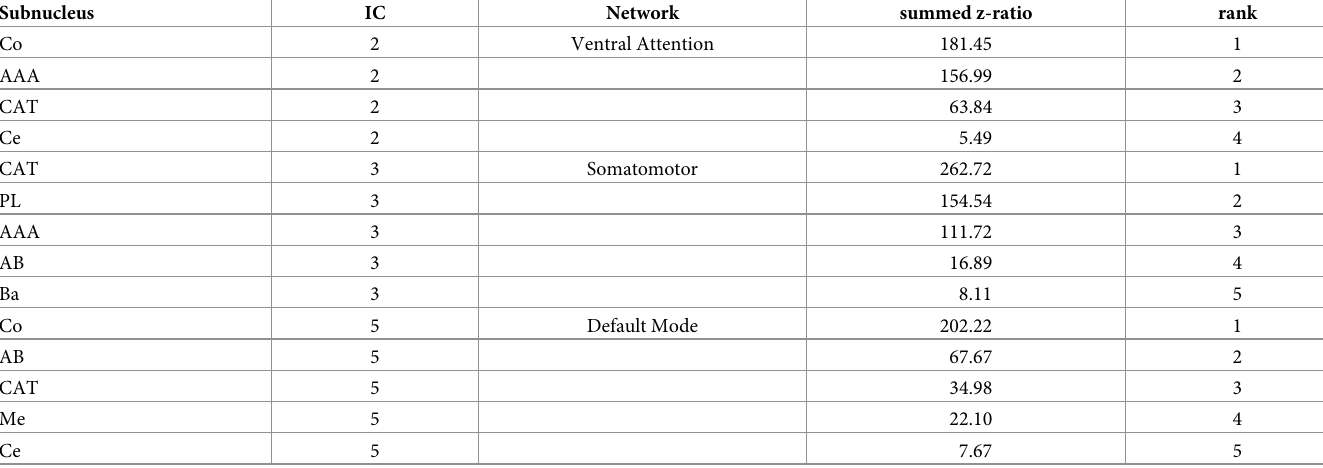
Table 7. Relative contributions of each amygdaloid subnucleus within the different resting-state networks. Rankings based on the sum of pairwise z-ratio differences for all subnuclei within a given IC. Subnucleus IC Network summed z-ratio rank 2 Ventral Attention